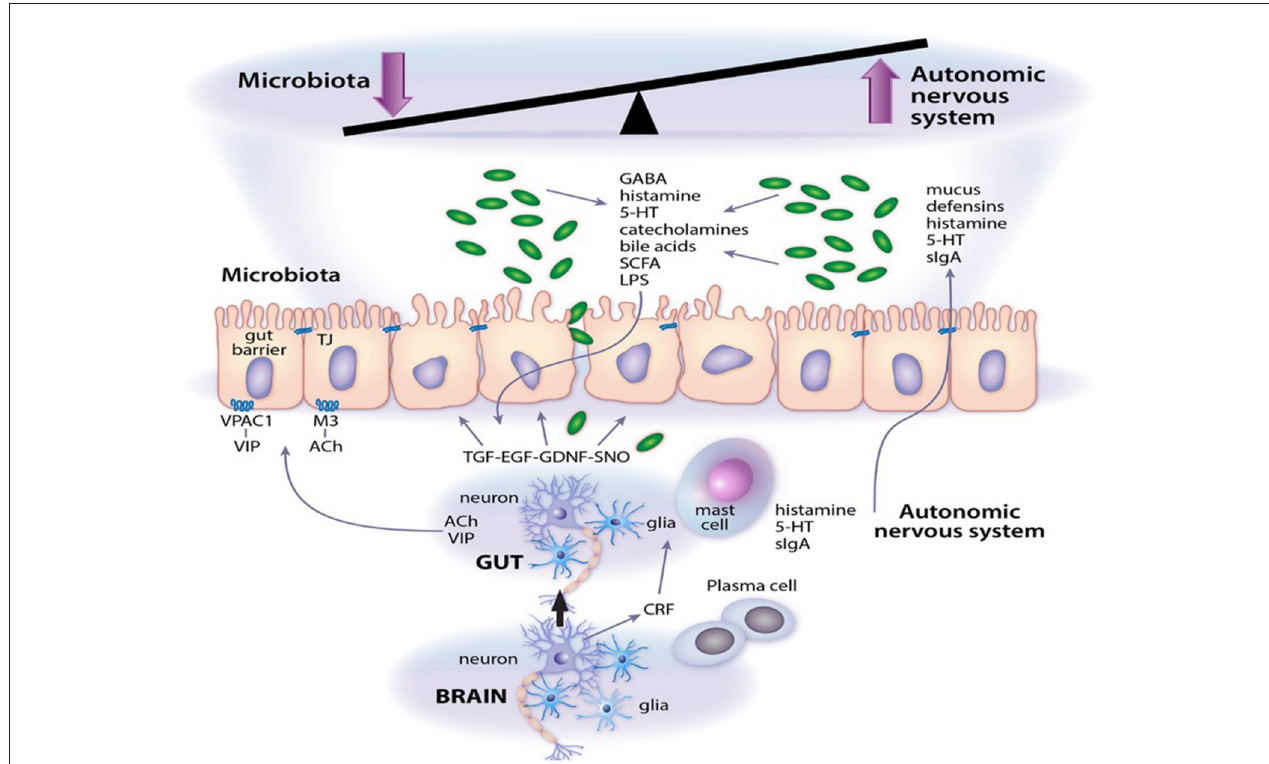
FIGURE 1 | Microbial neurotransmitter crosstalk with the autonomic nervous system. As outlined in the article, a system of checks and balances operate to regulate gut function. Abbreviations: 5-HT, serotonin; Ach, acetylcholine; CRF, corticotrophin releasing factor; EGF, epidermal growth factor; GDNF, glial cell line-derived neurotrophic factor; LPS, lipopolysaccharide; M3, M3 muscarinic receptor; SCFA, short chain fatty acids; sIgA, secretory IgA; SNO, s-nitrosothiol; TGF, transforming growth factor; VIP, vasoactive intestinal peptide; VPAC1, VIP and PACAP receptor 1.